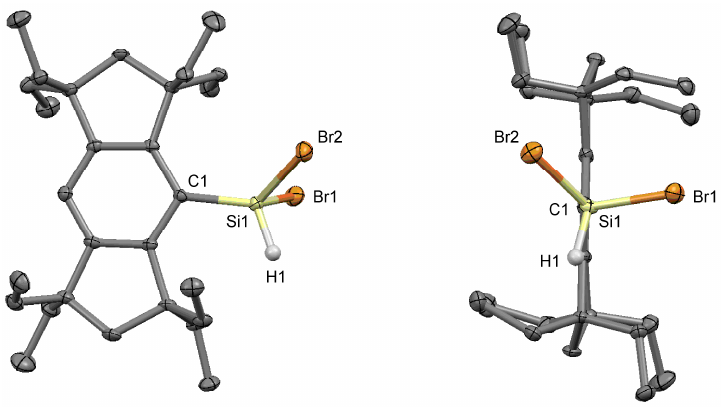
Figure 3. Molecular structure of 4a : Side view ( left ), front view ( right ). The thermal ellipsoids are shown at the 50% probability level. The hydrogen atoms, except for the Si–H group, are omitted for clarity.